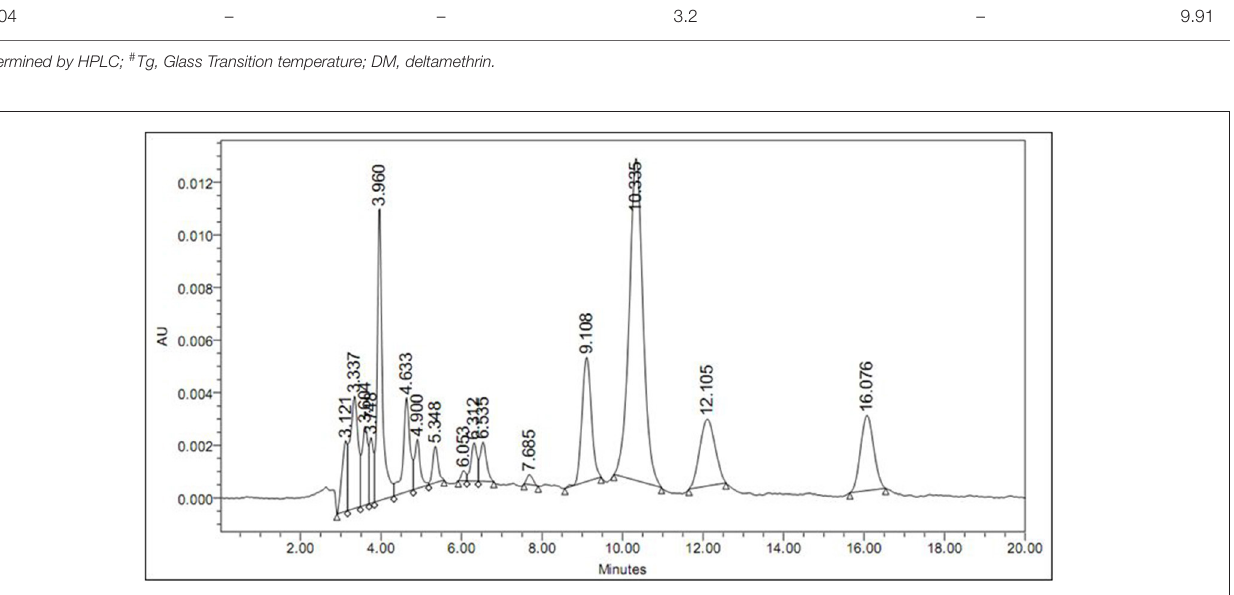
and 1 ml/min, respectively. Standard solution was prepared